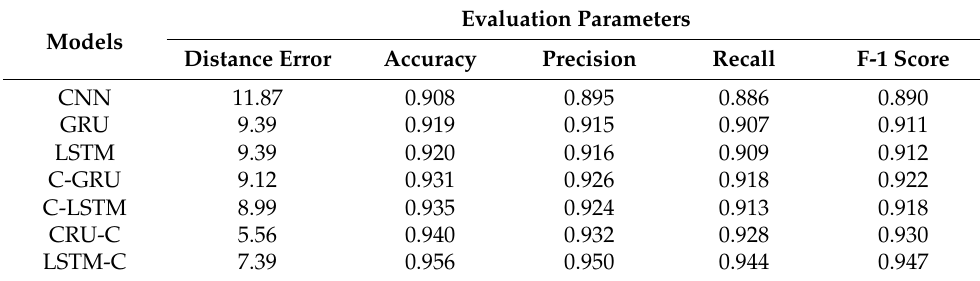
Table 2. Accuracy of deep learning model for data of 12